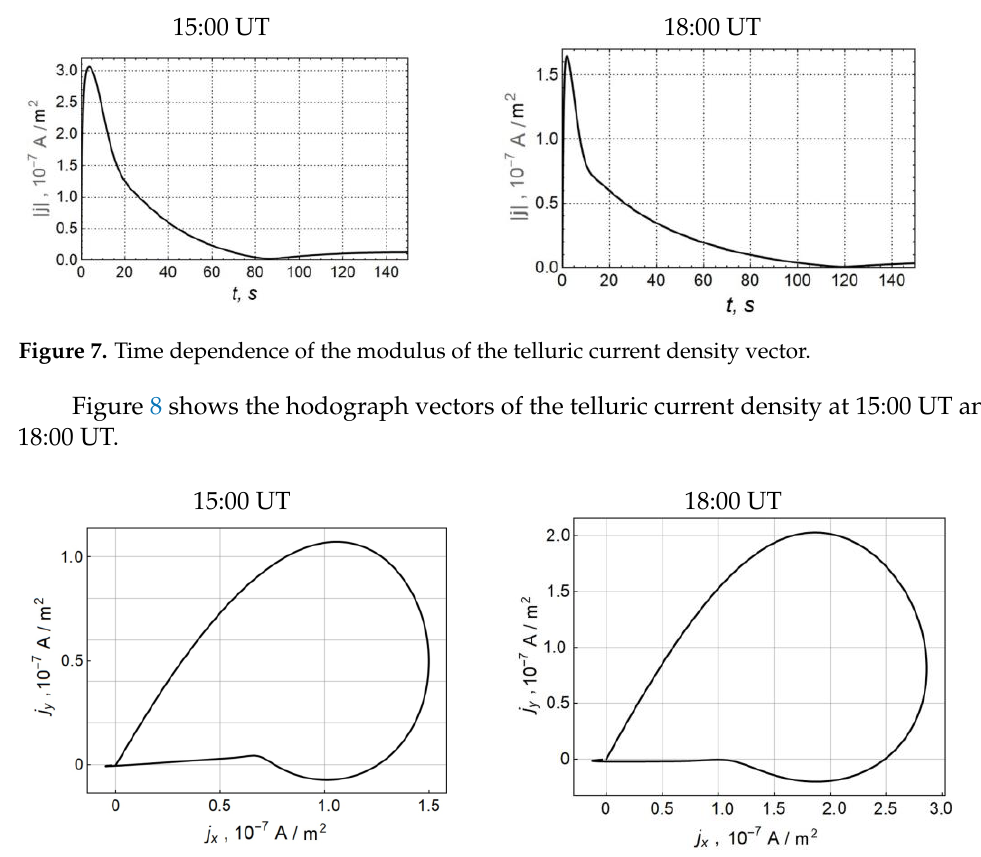
Figure 8. Hodograph vectors of the telluric current density.